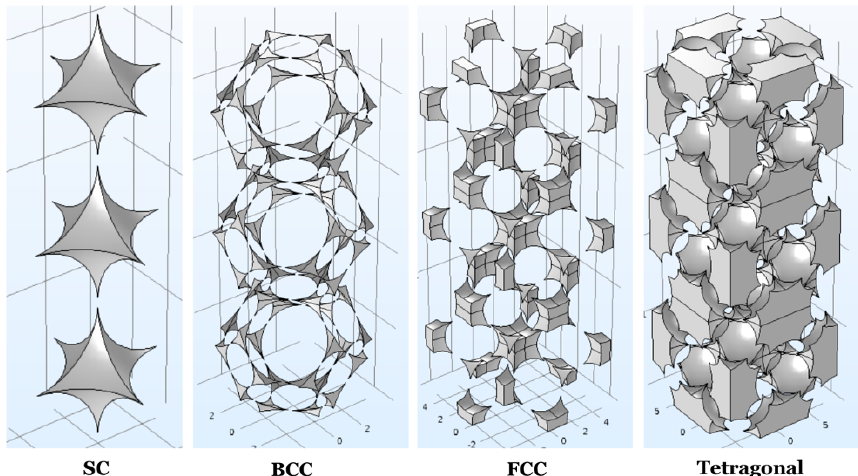
Figure 10. Example of morphology of structures below the limit porosity value ( ε Lim ). The disconnected islands represent the remaining inner voids not available for